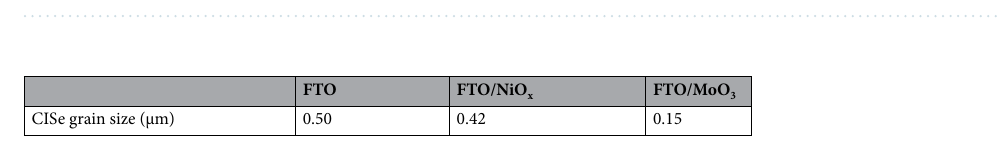
Figure 3. Surface and cross-sectional FESEM images of CISe films on: ( a,d ) FTO, ( b,e ) FTO/NiO x , ( c,f ) FTO/ MoO